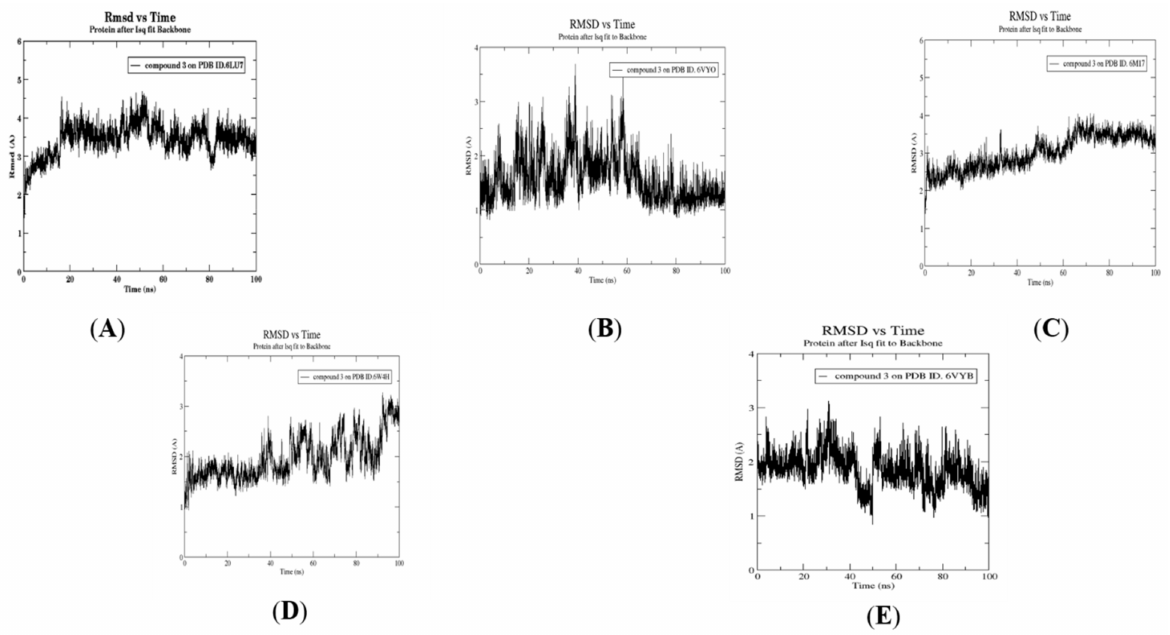
Figure 10. Dynamics of compound 3 bound to PDB ID: 6LU7 ( A ), 6VYO ( B ), 6M17 ( C ), 6W4H ( D ) and 6VYB ( E ), respectively. RMSD analysis of compound 3 against the five target proteins.